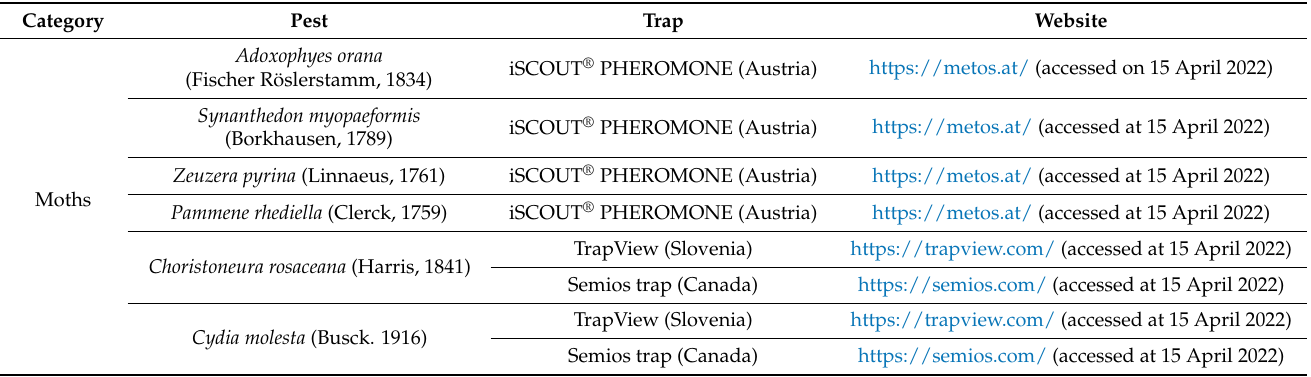
Table 3. Commercially available devices for the automatic monitoring of other important apple